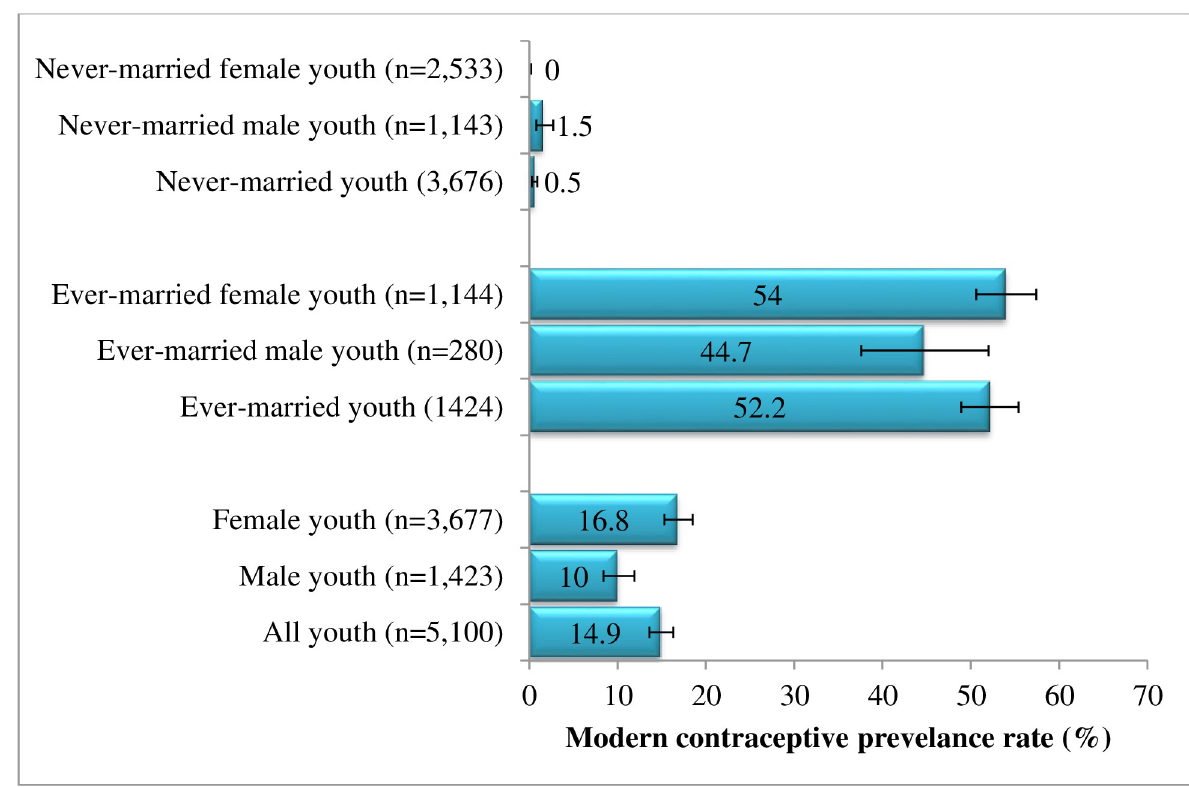
Fig 2. Prevalence of modern contraceptive utilization among youth in